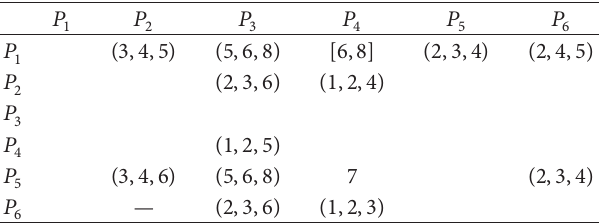
Table 10: Pairwise comparisons of alternatives with mixed prefer- ences (Example 2).